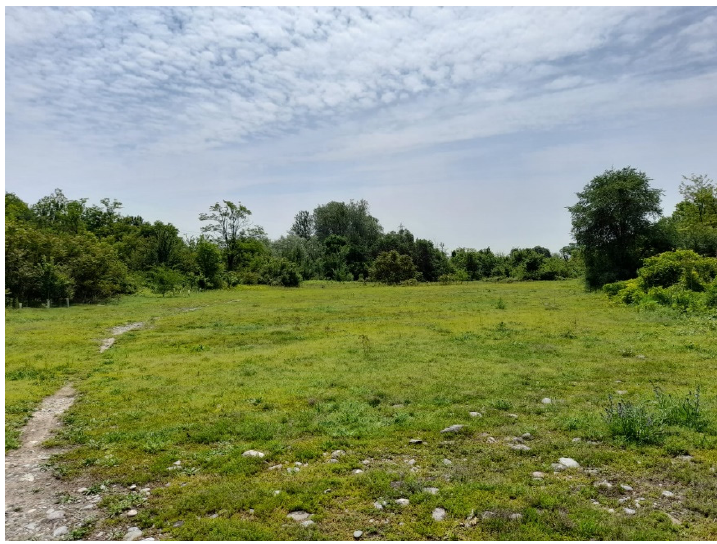
Figure 2. Malpaga-Basella Nature Reserve, station 1, characterized by high stone content and low plant cover (photo P. Gaini).